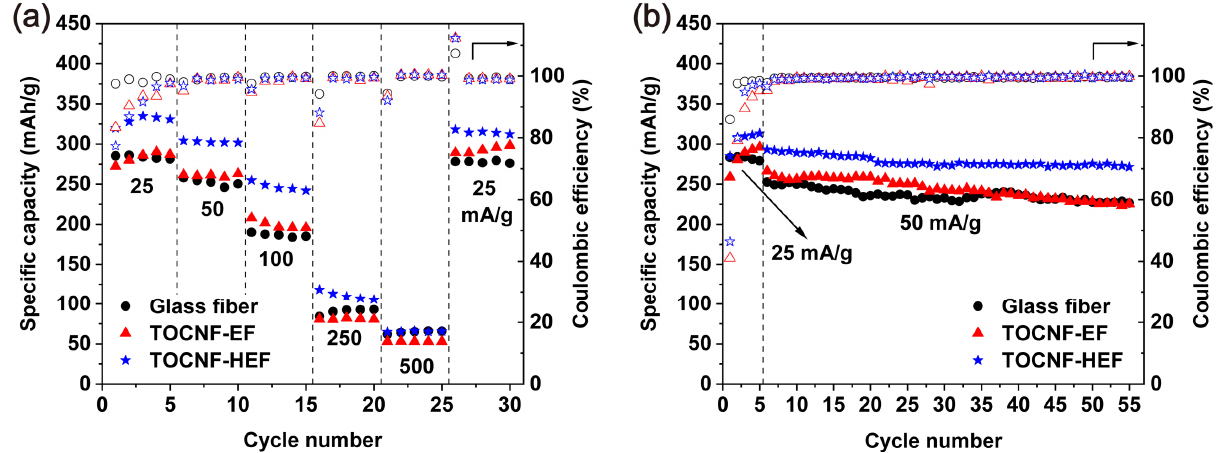
Figure 6. Electrochemical performance of TOCNF-EF and TOCNF-HEF at room temperature: ( a ) Rate performance at the rates of 25, 50, 100, 250 and 500 mA/g; ( b ) cycling performance at 25 mA/g for 5 cycles and then at 50 mA/g for 50 cycles under the voltage range of 0–2 V.